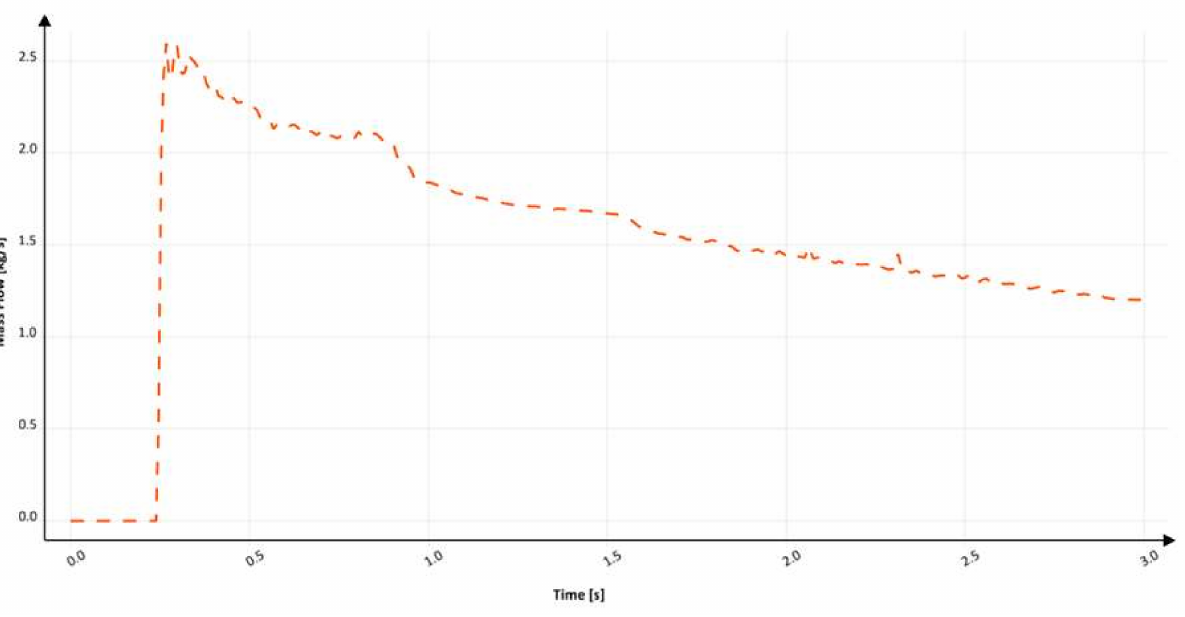
Figure 33. Mass flow through an ingate with thick rectangular sprue with hyperbolic taper (S s 8), MAGMASOFT.